Question: Which visualization type does this figure use?
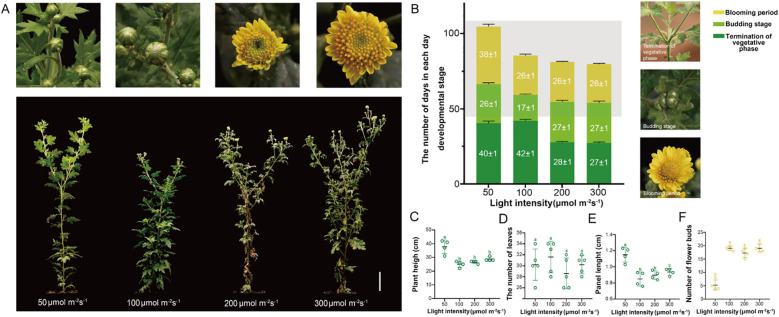
Answer: line